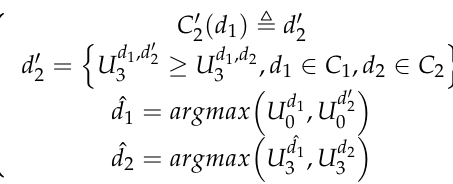
Figure 4. The change trend of 𝑈 (cid:3030)(cid:3042)(cid:3040)(cid:3033)(cid:3042)(cid:3045)(cid:3047) − 𝑡 (cid:3030)(cid:3028) .